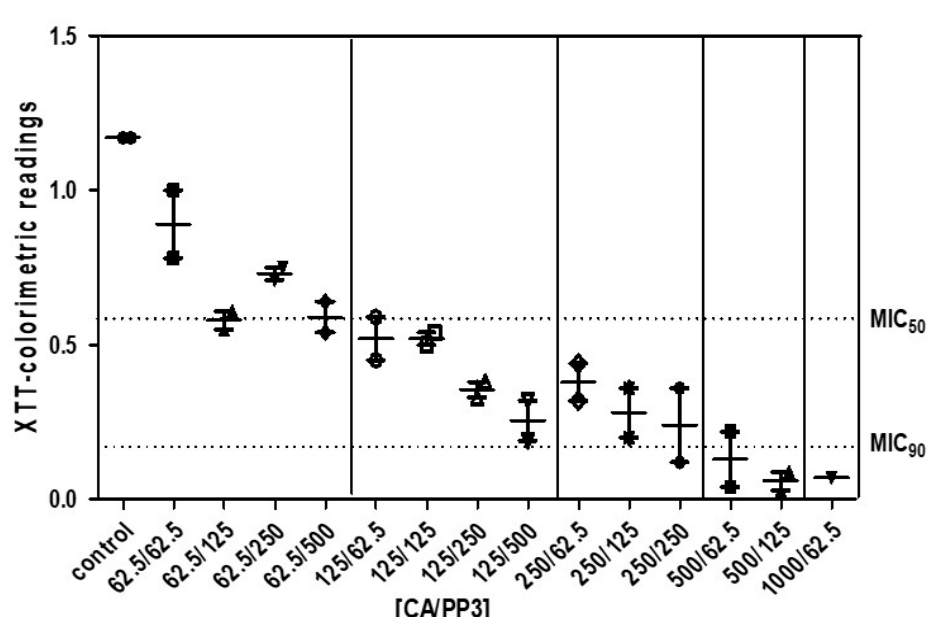
Figure 5. Inhibitory effect of different mixtures of CA and PP on the viability of preformed biofilms recorded in C. neoformans H99 strain. Planktonic cells were allowed to adhere on the surface of polystyrene 96-well microtiter plates at 27 ◦ C for 24 h. After addition of the extracts during further 24 h, the metabolic activity of these preformed biofilms was quantified by the XTT reduction assay (see Methods). The results are expressed as the mean ± standard deviation of two experiments with six replications for each group. The concentrations of CA and PP are expressed as µg/mL.